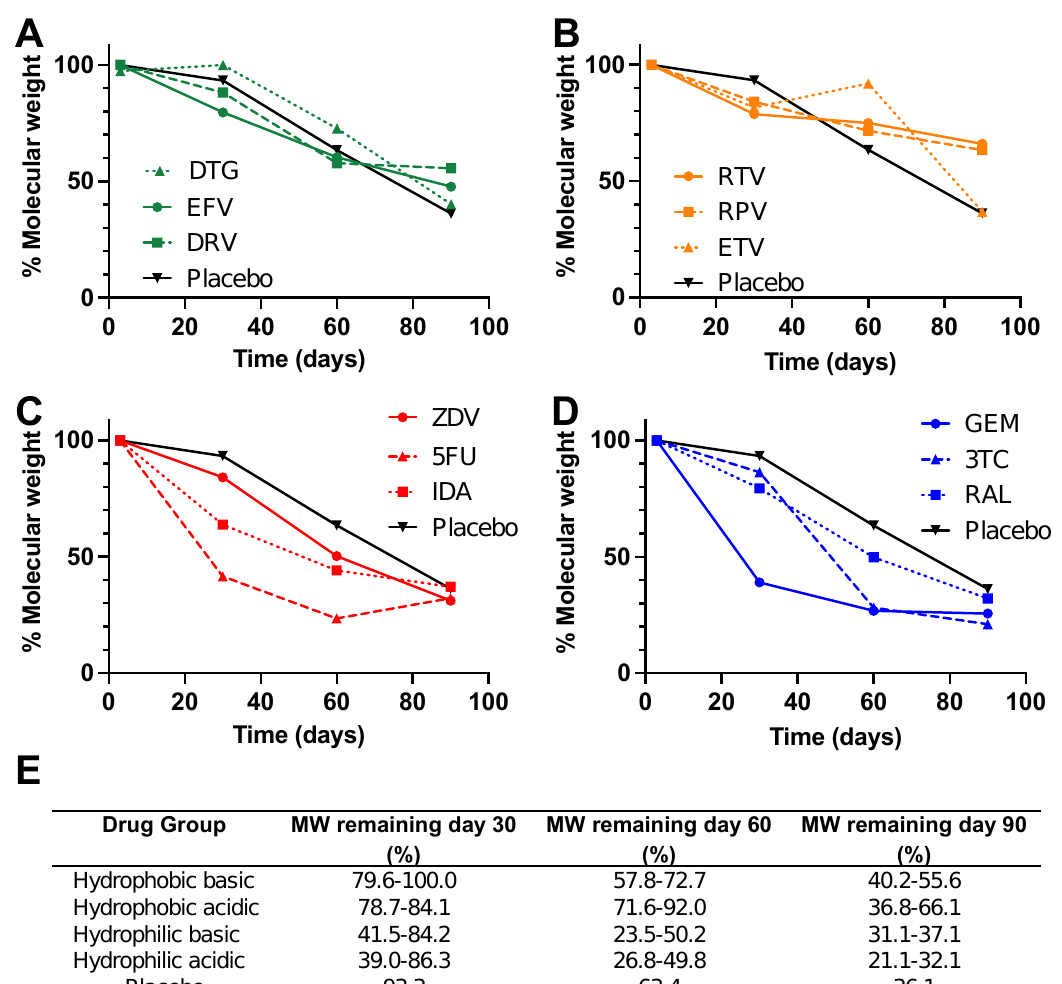
Figure 6. Percent PLGA MW decrease of drug-loaded ISFIs (50 mg/g drug in 1:2 w / w PLGA:NMP) over 90 days for ( A ) hydrophobic–basic drugs, ( B ) hydrophobic–acidic drugs, ( C ) hydrophilic–basic drugs, and ( D ) hydrophilic–acidic drugs. ( E ) Shows the numerical values of % molecular weight remaining at days 30, 60, and 90. The initial MW of PLGA (100% MW; time 0) for each ISFI was determined by analyzing depots post 3 days incubation in PBS at 37 °C to allow full removal of solvent from the ISFI. The remainder of PLGA MW data were normalized as a percent of the initial PLGA MW quantified at time 0.